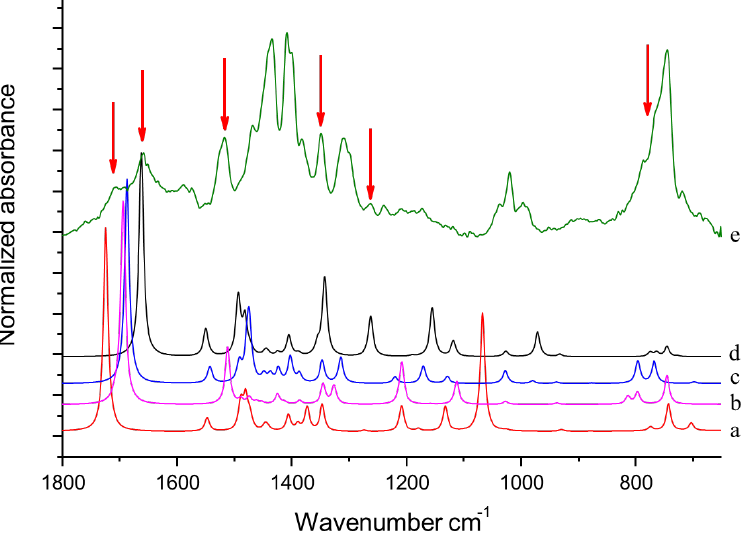
Figure 4. DFT computed spectra of: DMP-COOH (a), MP-(CHO) 2 (b), DMP-CHO (c), and DMP-COOH H-bonded dimer (d). The experimental reference spectrum (e) of modified TMP (sample treated at 130 °C in the absence of HSAG, spectrum recorded after TMP evaporation) is reported, where red arrows indicate absorption features, which can be rationalized with the occurrence of the oxidized species.